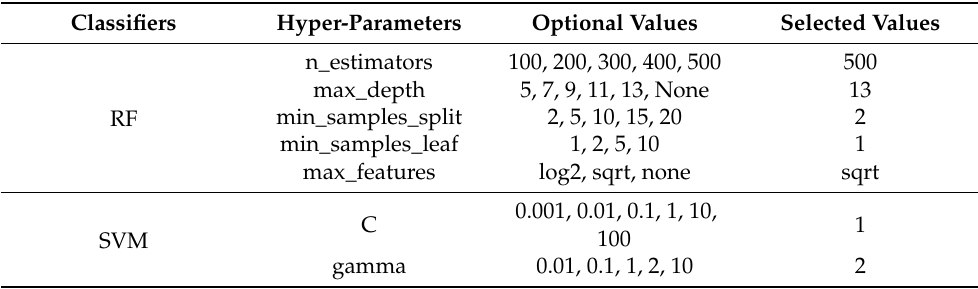
Table 2. Specifications about the hyper-parameters of the two machine-learning models (RF and SVM) used in this